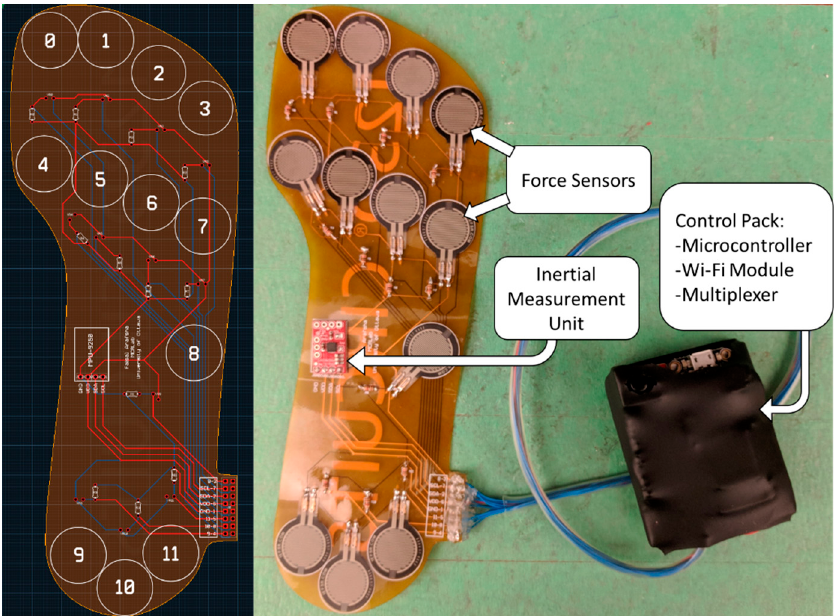
Figure 5. Left: Printed Circuit Board (PCB) design showing sensor layout, Right: actual photo of implemented device on flexible PCB.